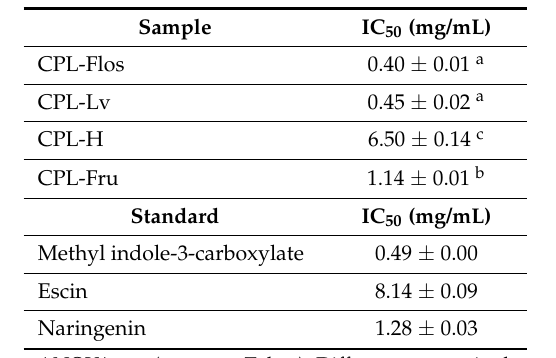
Table 4. Anti-hyaluronidase potential of R. rugosa CPL. Results expressed as mean IC 50 values ± SD ( n = 3). Abbreviations like in Table 2.